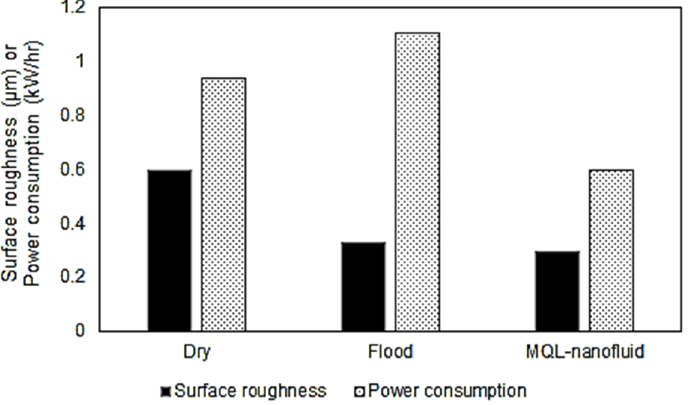
Figure 10. The selected optimal results for Model I (machining performance-based model).